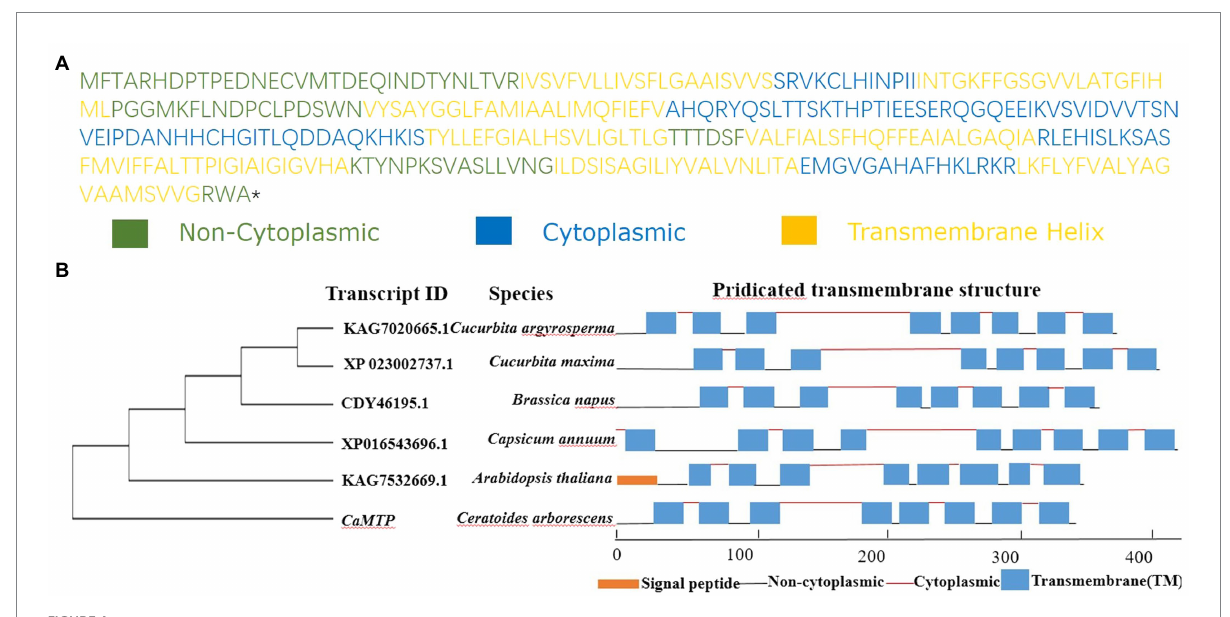
FIGURE 4 ( A ) Protein sequence of CaMTP . ( B ) Phylogenetic and structure comparison of CaMTP with other similar plant protein sequences. Different protein structure components are illustrated with different colors as